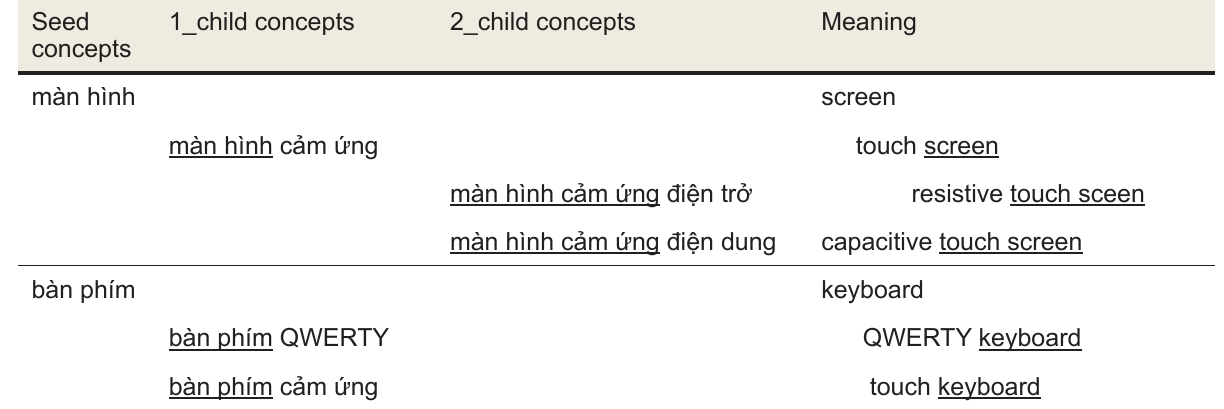
An Example of Child-Concepts Generalization using Seed Concepts and Prefix-Based Con - cept Discovery